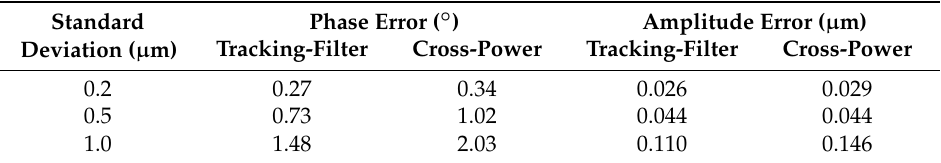
Table 3. Measurement error analysis of the vibration